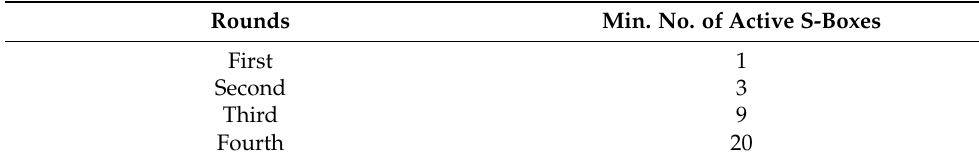
Table 6. Minimal Number of Active S-boxes in the Differential Characteristics.